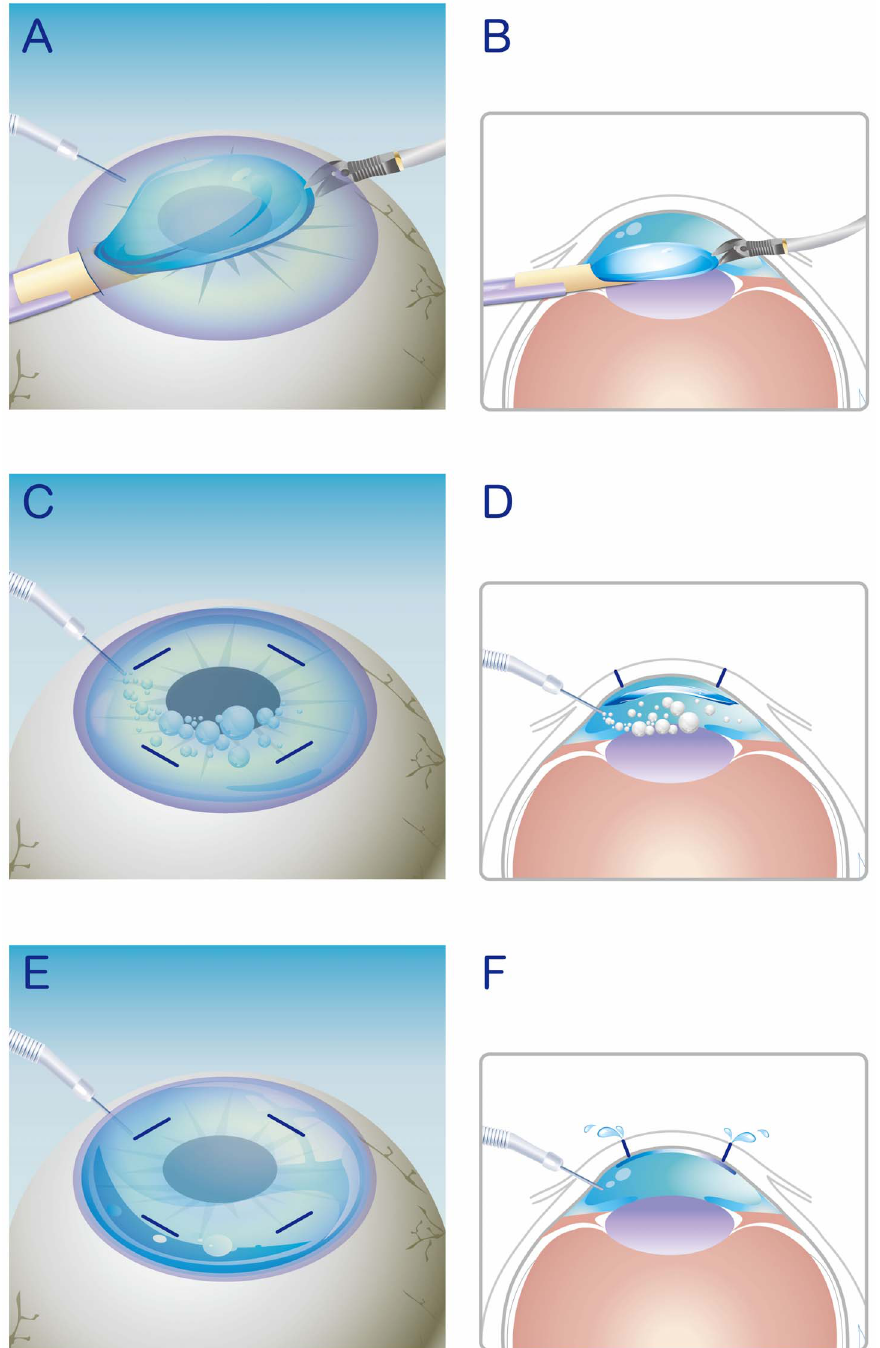
Figure 1. Schematic illustration of the modified DSAEK procedure. A, B) Donor tissue insertion. C, D) Continuous air pumping. E, F) Drainage of interface fluid from venting